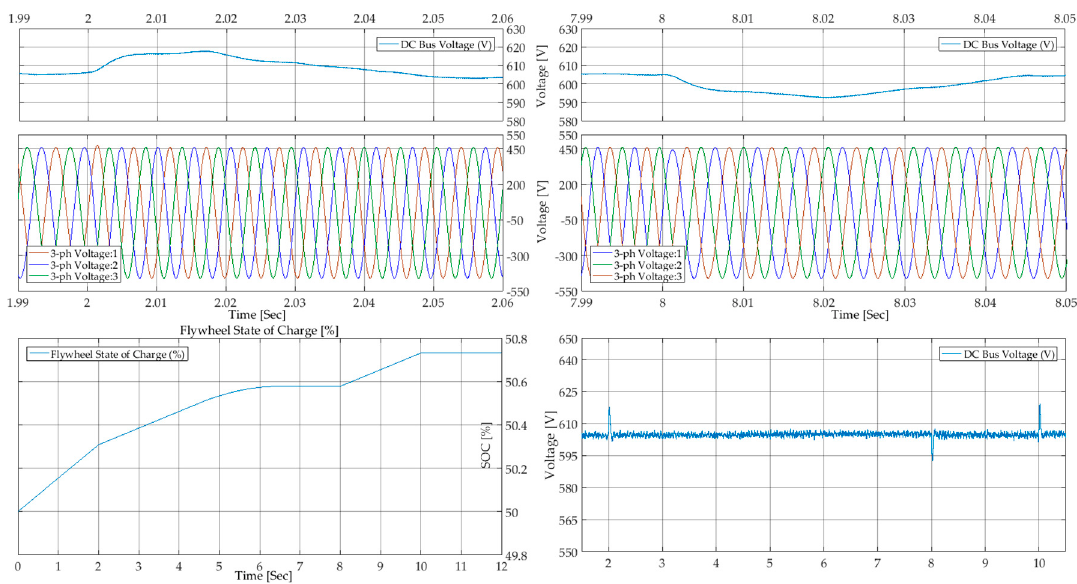
Figure 15. FESS in step-charging mode: Inverter output voltage and DC-bus voltage at ( t = 2 s ) (top left); Inverter output voltage and DC-bus voltage at ( t = 8 s ) (top left); FESS state-of-charge (bottom left); DC-bus voltage at ( t = 2, 8,& 10 s ) (bottom